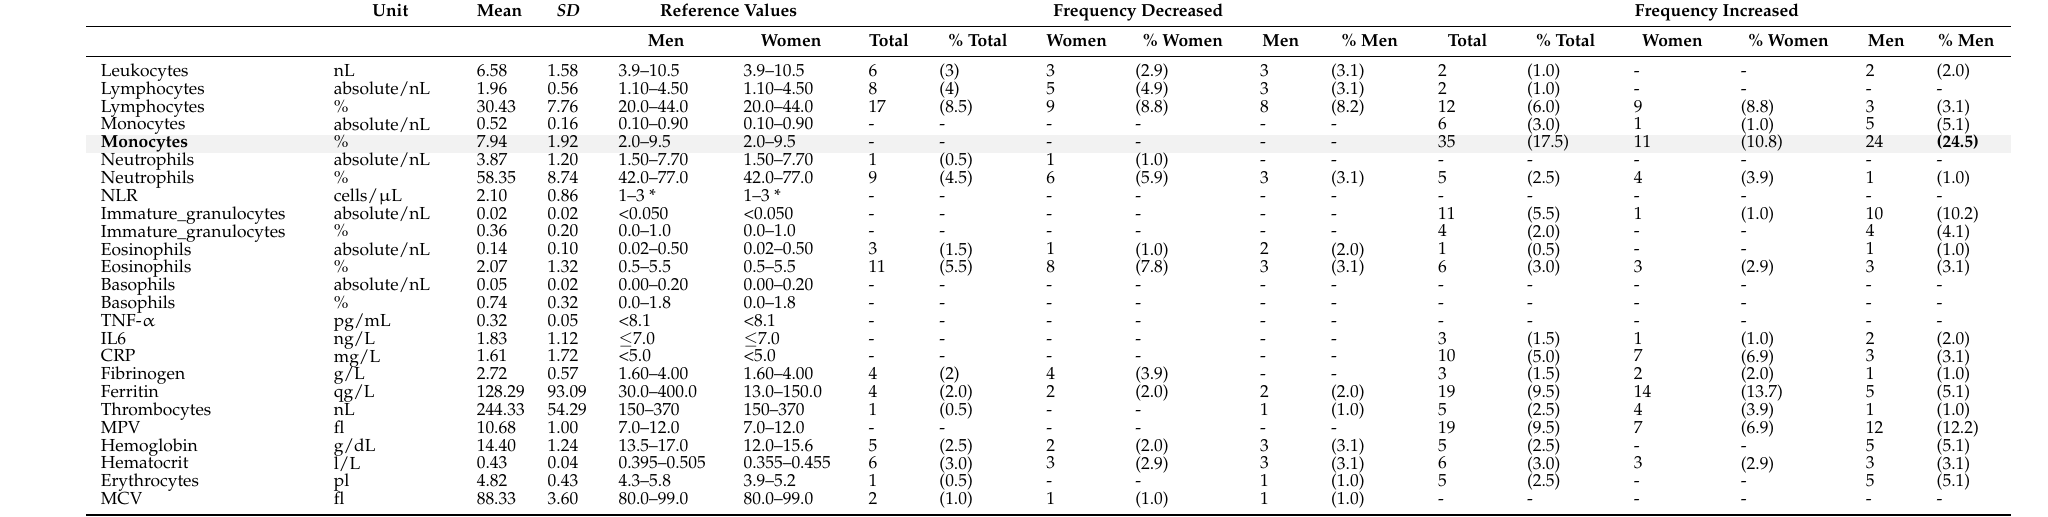
Table 5. Means, standard deviations, reference values, and frequency rates of participants with increased or decreased non-vascular-metabolic blood parameters. Indices with ‘outstanding’ rates of ≥ 25% are highlighted for